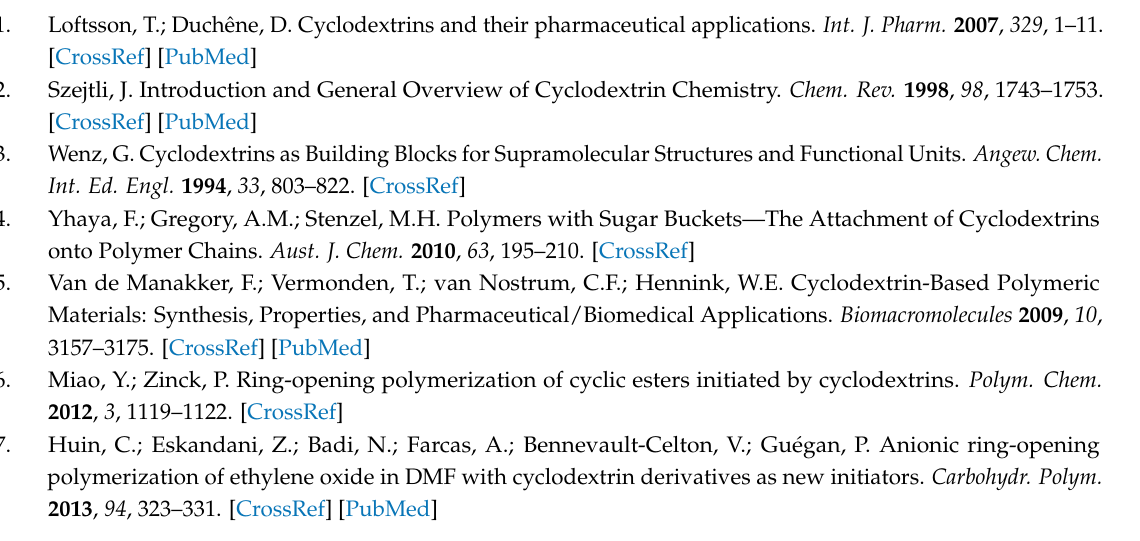
Figure S2: GPC results for the CD-LA, Figure S3: ESI MS spectrum of CD-LA (low molecular weight fraction), and Table S1: Fragment peak intensities (I r ) observed in the MS/MS spectra of the K-charged precursor